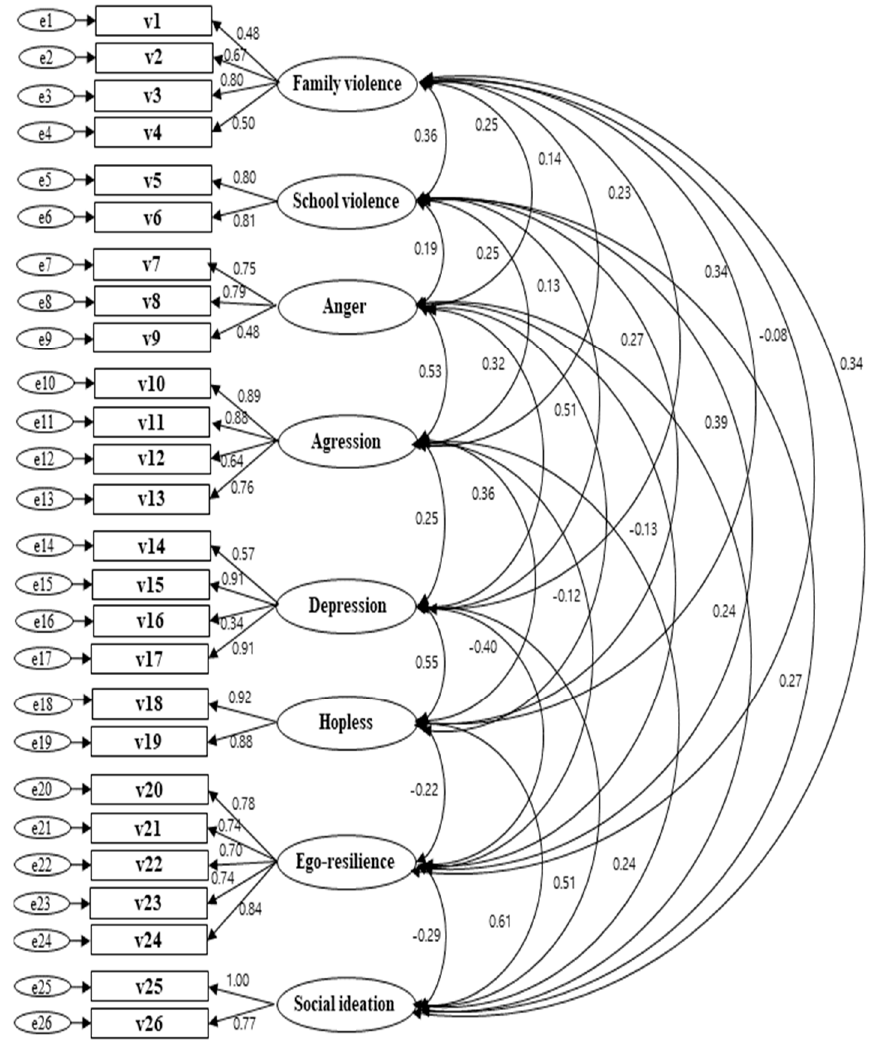
Figure 3. Confirmatory factor